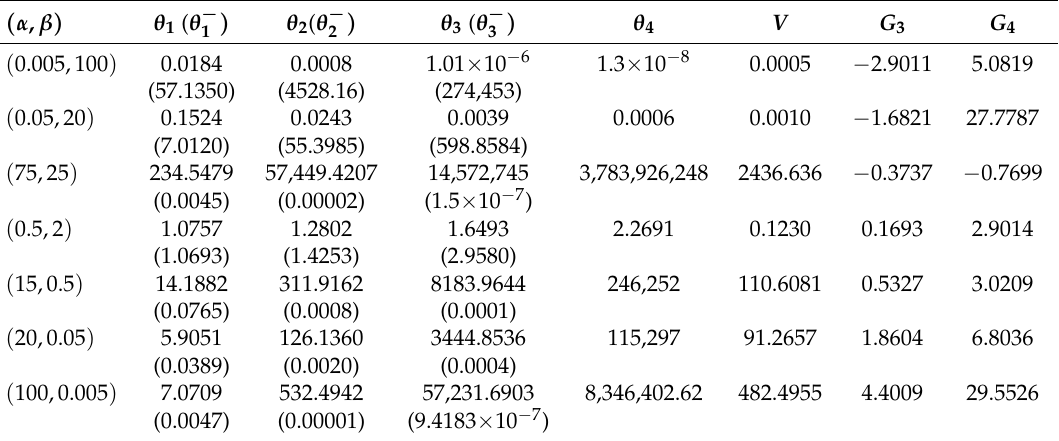
Table 1 indicates numerical values for moments (standard and negative), asymmetry and kurtosis of the MOLBM distribution for selected values of parameters α and β . Table 1. Numerical values for moments, asymmetry and kurtosis of the MOLBM distribution for selected values of the